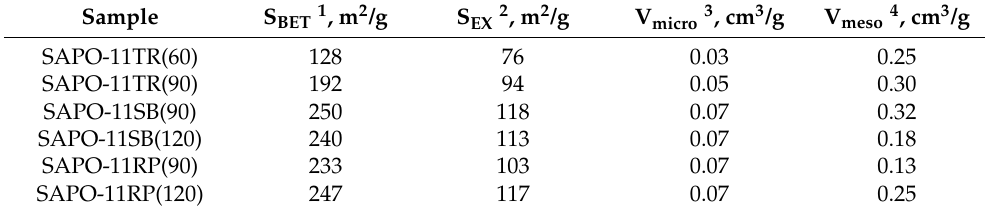
Table 5. Characteristics of the porous structure of molecular sieves.